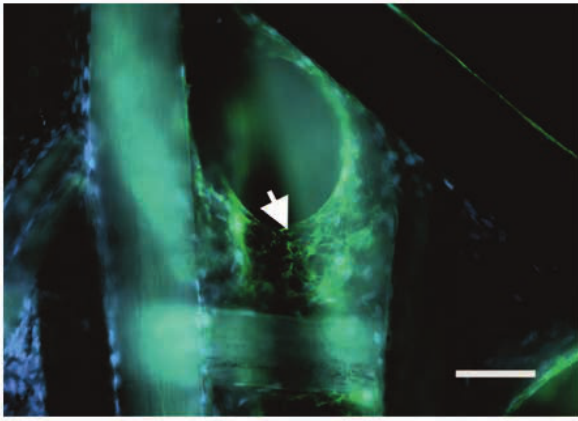
Figure 5: Confocal laser scanning microscope observation of the rMSC growth on F-KAPs stained with vimentin and Hoechst, arrow shows rat mesenchymal stem cells, scale bar = 200